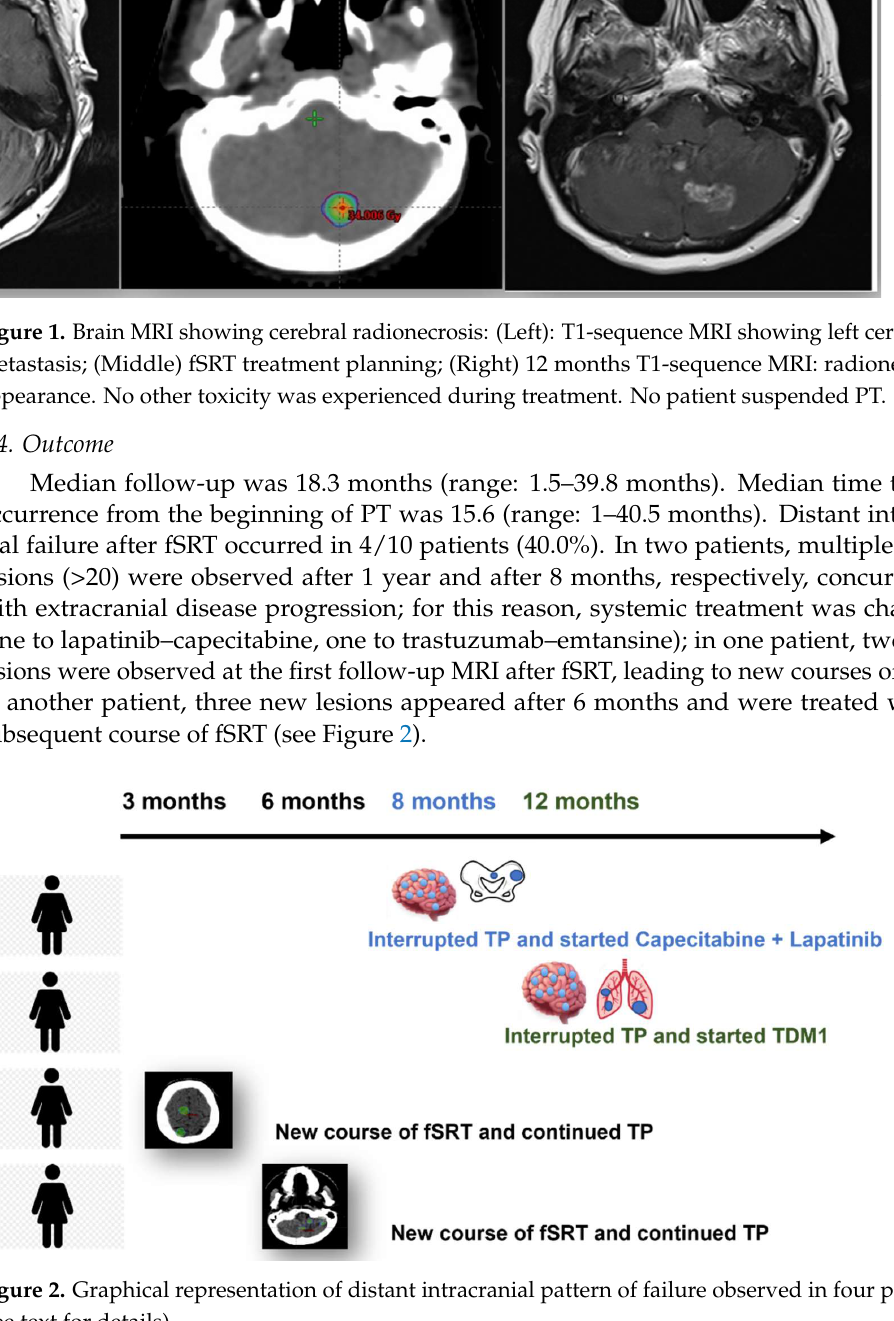
Figure 2. Graphical representation of distant intracranial pattern of failure observed in four patients (see text for (see text for details).